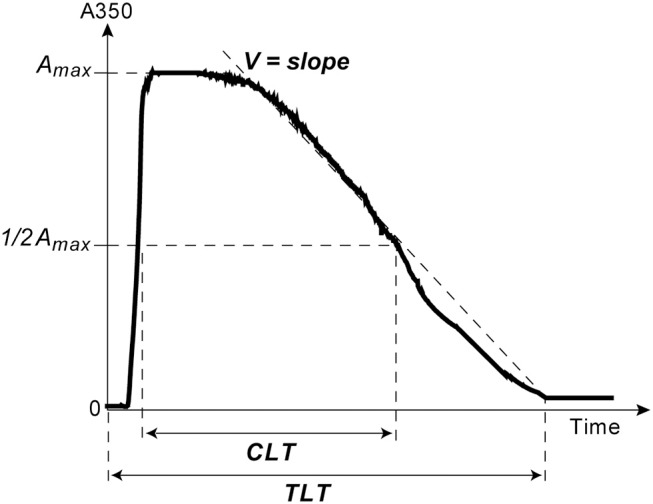
A typical turbidimetry curve of fibrin formation and lysis with the following extracted parameters of intrinsic fibrinolysis: (1) Total Lysis Time (TLT), i.e., the time from adding CaCl2 and t-PA until the time point when the OD almost reaches the baseline and does not change any more, which corresponds to complete clot dissolution; (2) the rate of fibrin lysis (V), i.e., the slope of the descending limb of the curve between the end of the horizontal plateau and the end point of TLT; (3) the time needed to reduce the maximum turbidity of the clot to the half-maximal value (t1/2); (4) Clot Lysis Time (CLT), which was defined as the time from the midpoint of the clear to maximum turbid transition to the midpoint in the transition from maximum turbidity to the final baseline turbidity (38).